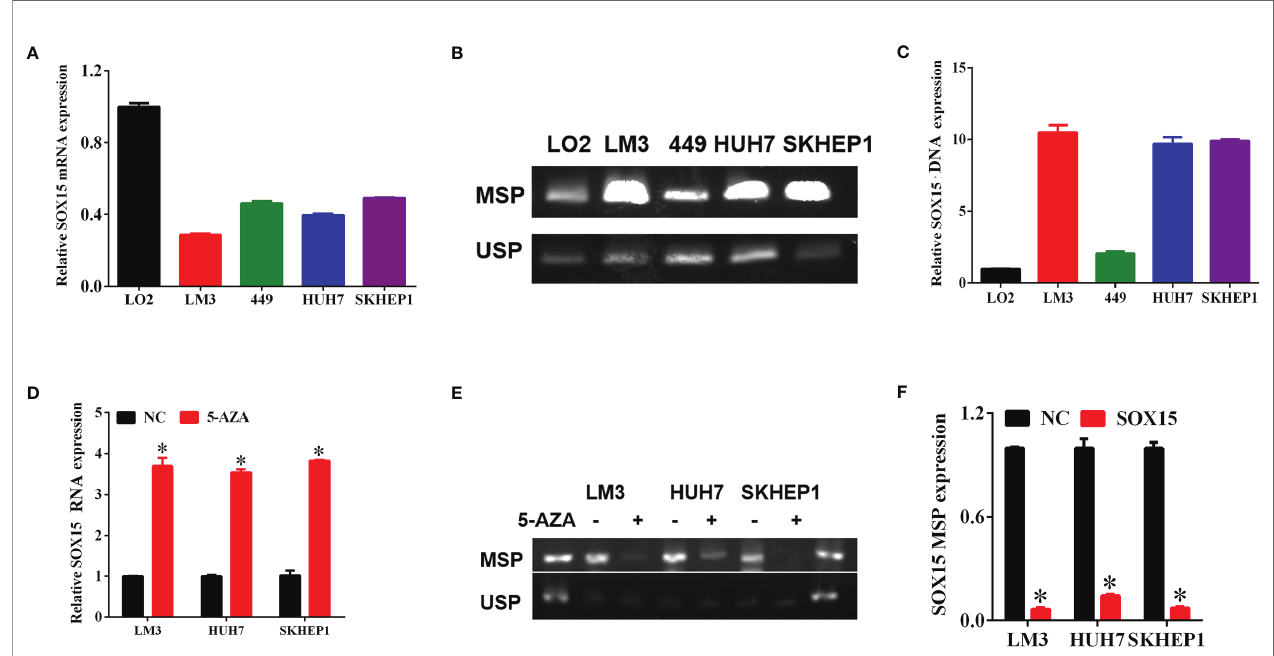
FIGURE 4 | The silencing of Sox15 was governed through promoter methylation within HCC cells. (A) Sox15 mRNA levels within HCC cells measured through RT- qPCR. (B, C) Sox15 promoter methylation status is measured by MSP and USP and quanti fi cation. (D) Sox15 mRNA levels within HCC cells measured by RT-qPCR post-exposure to 5-Aza. (E, F) Sox15 promoter methylation status is measured by MSP and USP and quanti fi cation post-exposure to 5-Aza. MSP, methylation speci fi c PCR; USP, unmethylation speci fi c PCR; *p <